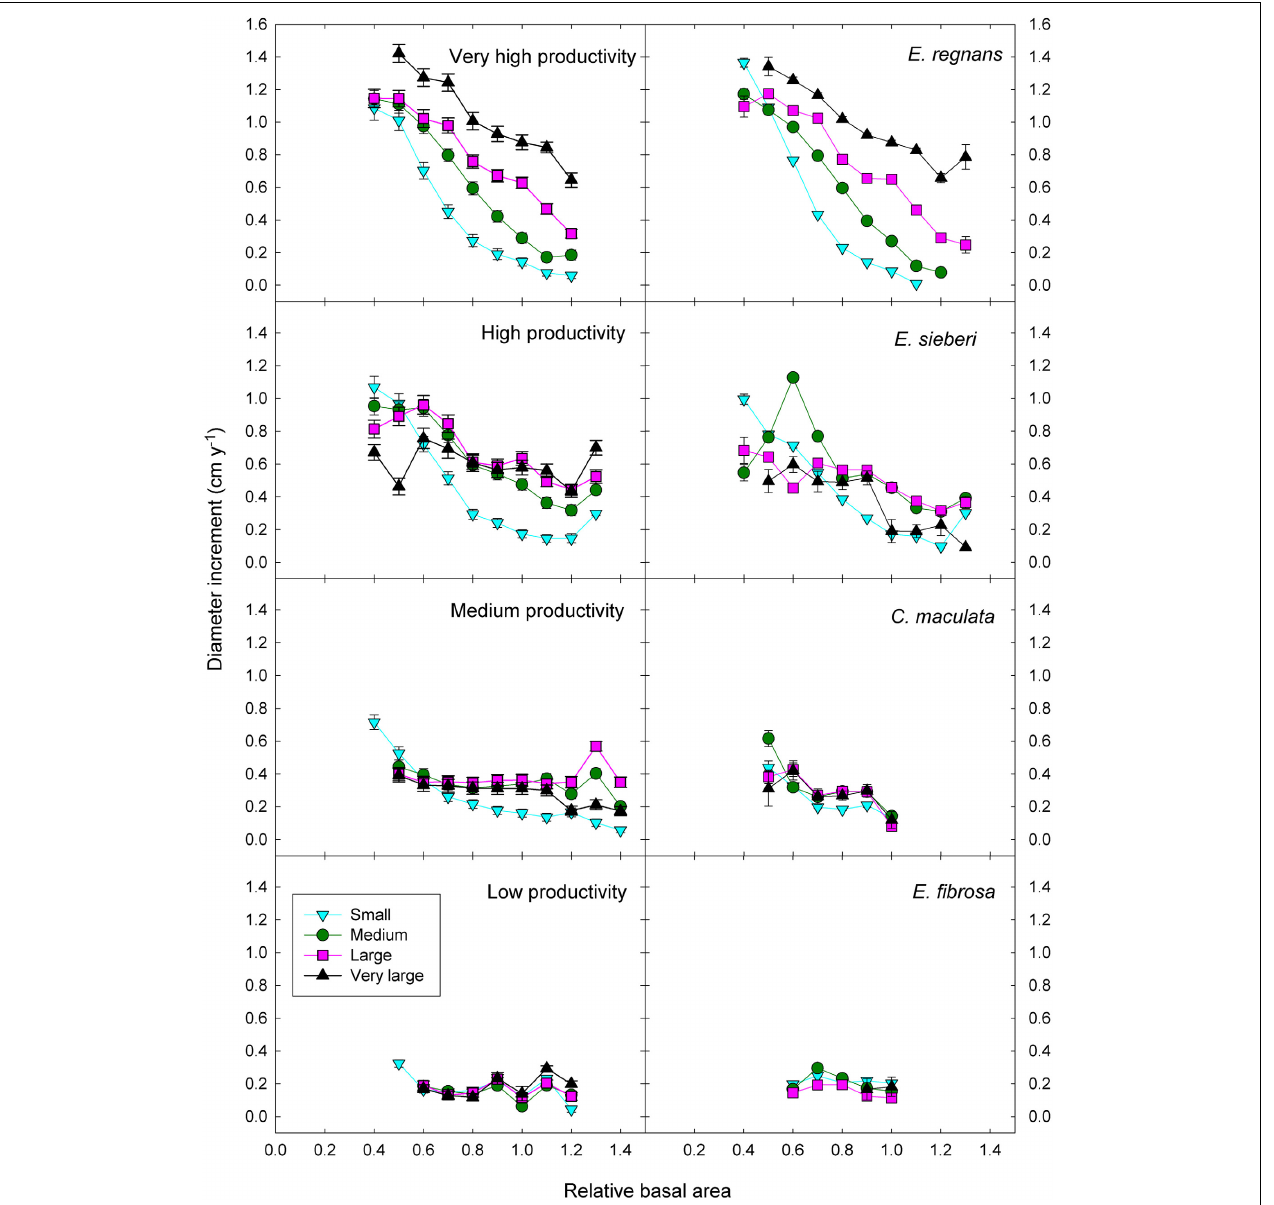
FIGURE 7 | Eucalypt diameter growth in relation to relative basal area, tree size, and climatic productivity category. Data for a representative species growing in the climatic productivity category is